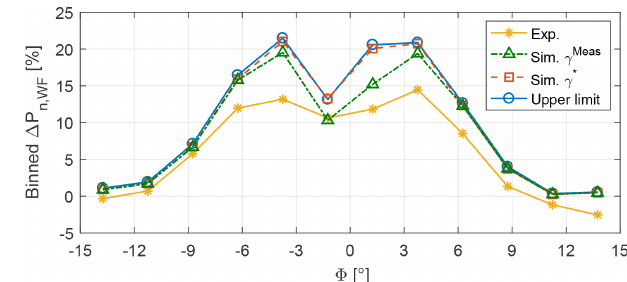
Figure 13. Wind farm power gains with respect to the greedy policy vs. wind direction (cid:56) . Tests were performed with zero wind direc- tion uncertainty ( σ (cid:56) = 0 ◦ ), and LUTs were synthesized from the baseline FLORIS